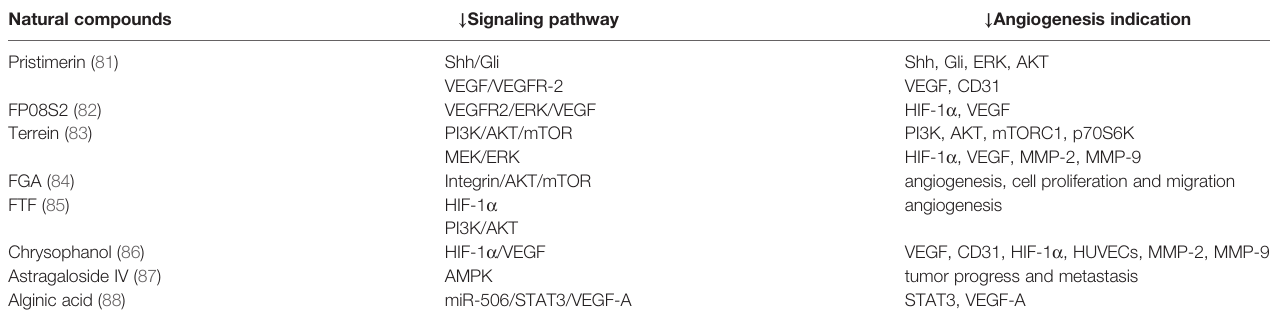
TABLE 5 | Research progress of existing natural compounds in angiogenesis in lung cancer. Natural compounds ↓ Signaling